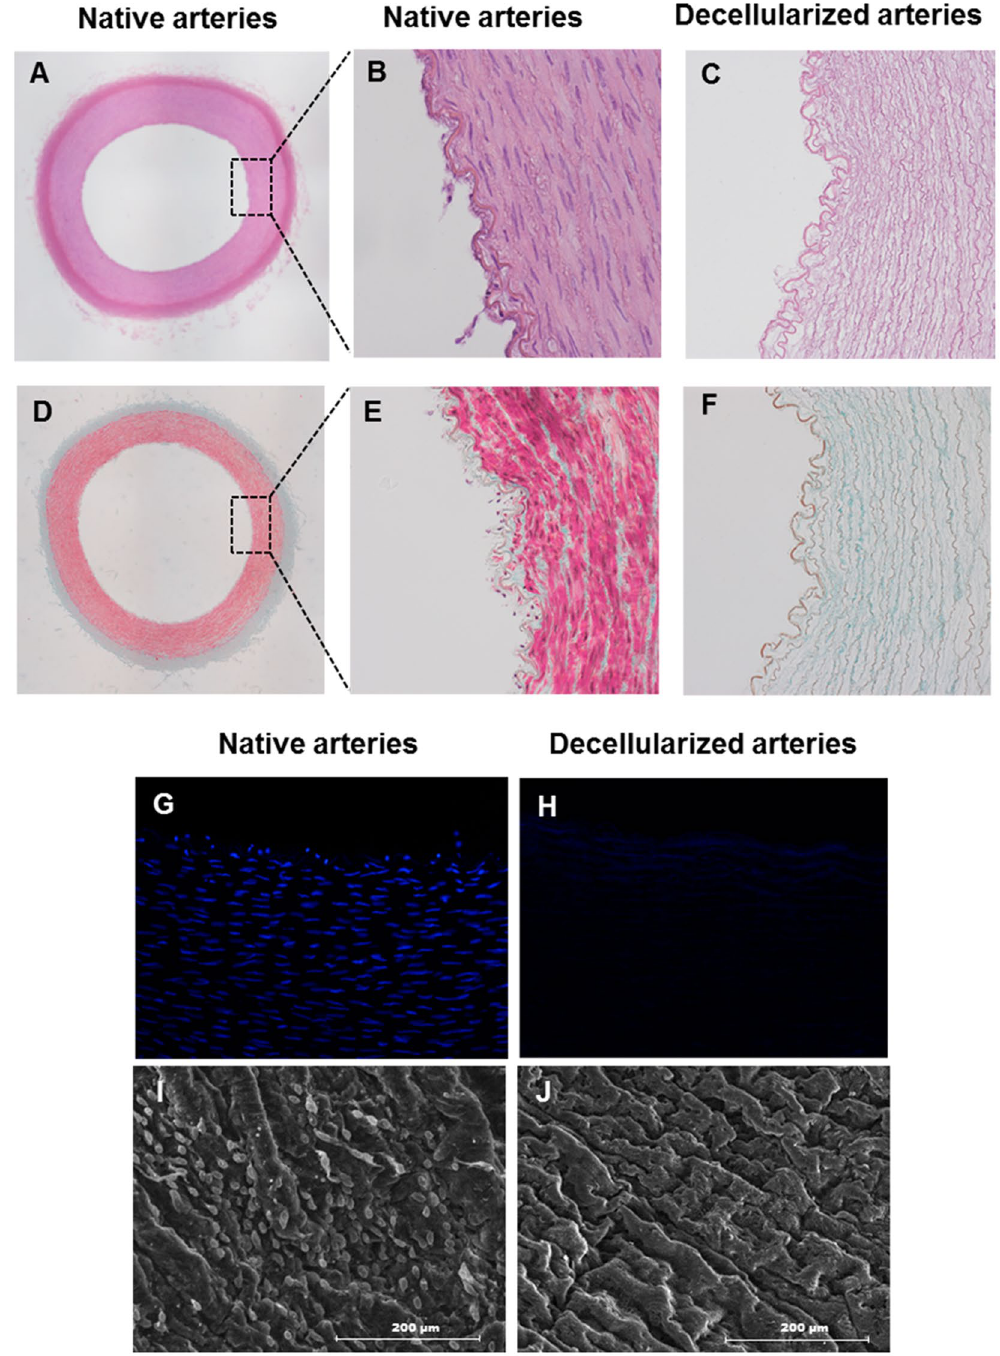
Figure 3. Characterization of porcine carotid arterial tissue before and after decellularization. Histology of porcine arteries: ( A , B , D and E ) native arteries and ( C and F ) decellularized arteries. ( A and B ) H&E staining of native arteries (magnification; x4 and x10, respectively). ( C ) H&E staining of decellularized arteries demonstrating complete removal of cellular components (magnification; x10). ( D and E ) Masson’s Trichrome staining of native arteries showing high cell density embedded in collagens ECM (green fibers) (magnification; 4x and 10x, respectively). ( F ) Masson’s Trichrome staining of decellularized artery revealing preservation of the collagenous ECM and no cells (magnification; x10). Representative fluorescent microscope images of a circumferential cross section stained with DAPI: ( G ) Native arteries and ( H ) decellularized arteries (magnification; x20). SEM micrographs of the luminal surface: ( I ) native arteries and ( J ) decellularized arteries, scale bar indicates 200 μ